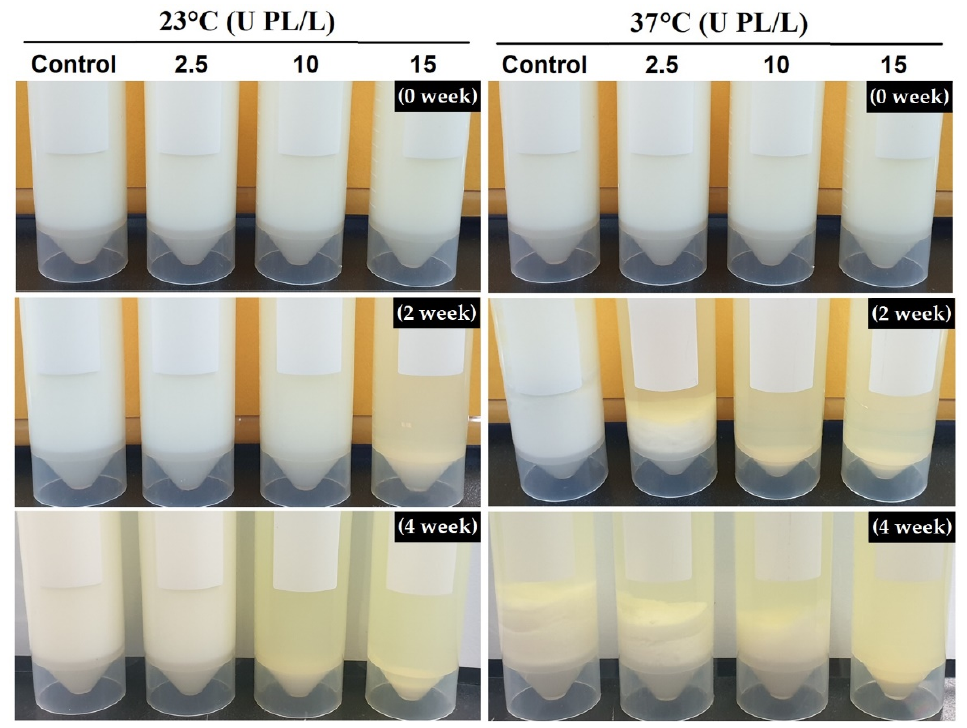
Figure 2. Changes in appearance of UHT skim milk containing 2.5, 10, and 15 U PL/L during storage. UHT, ultra-high temperature; PL, plasmin.